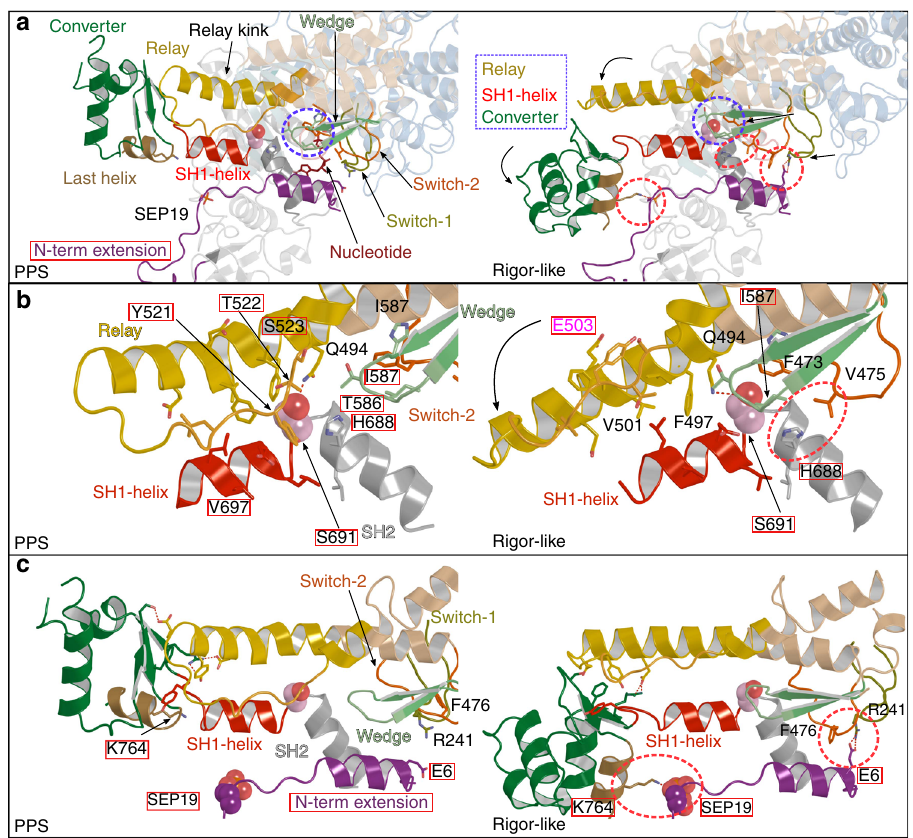
Fig. 4 The unconventional mechanism of force production by PfMyoA. a Overall view of the mechanical communication within the PfMyoA motor domain during the powerstroke. In both the PPS and the Rigor-like states, interactions between Switch-2 and the Wedge are maintained (highlighted by dashed blue lines and detailed in b ). The Rigor-like structure indicates that the sequential release of hydrolysis products upon the powerstroke triggers displacement of the Wedge which is associated with straightening of the Relay helix and the converter swing. The PfMyoA unconventional powerstroke requires sequence compensation near the Ser691 (blue dashed lines) since this residue is bulkier than the canonical SH2-SH1 Gly found in classical myosins at this position. Thus, motor domain rearrangements are allowed by changes in the interactions between the Wedge and the Relay and SH1-helix connectors (details in b ). Additional interactions (highlighted by dashed red lines) involving the N-term extension (purple) also stabilize the Rigor-like state and compensate for the immobility of the SH1-helix. (Details are shown using the same view in c ). b Non-conserved residues are highlighted by a red rectangle. The SH1-helix lacks the conserved glycine SH2-SH1 Gly at the fulcrum which is replaced by a serine (light pink spheres, S691). A hydrogen bond is formed between S691 and Relay Q494 in both the PPS and Rigor-like states. The presence of a less pliant fulcrum requires sequence adaptation in the Wedge and in the Relay and results in the immobility of the SH1-helix during the powerstroke. Switch-2 V475 establishes hydrophobic interactions with SH2 H688, helping to stabilize the Rigor-like position of the Switch-2 (red dashed lines). E503 (shown in pink) is a reporter to indicate the kink of the Relay. c In PfMyoA, the converter establishes a network of interactions with the Relay and the SH1-helix. Non-conserved residues are highlighted by a red rectangle. An electrostatic bond between phosphoserine 19 (SEP19) (N-term extension) and K764 (converter), as well as a salt bridge- π interaction between the N-term extension E6, Switch-1 R241, Switch-2 F476 (red dashed lines) stabilize the position of the converter in the Rigor-like conformation. For comparison with Myo2, see Supplementary Fig. 5 and Supplementary Movies 2 and